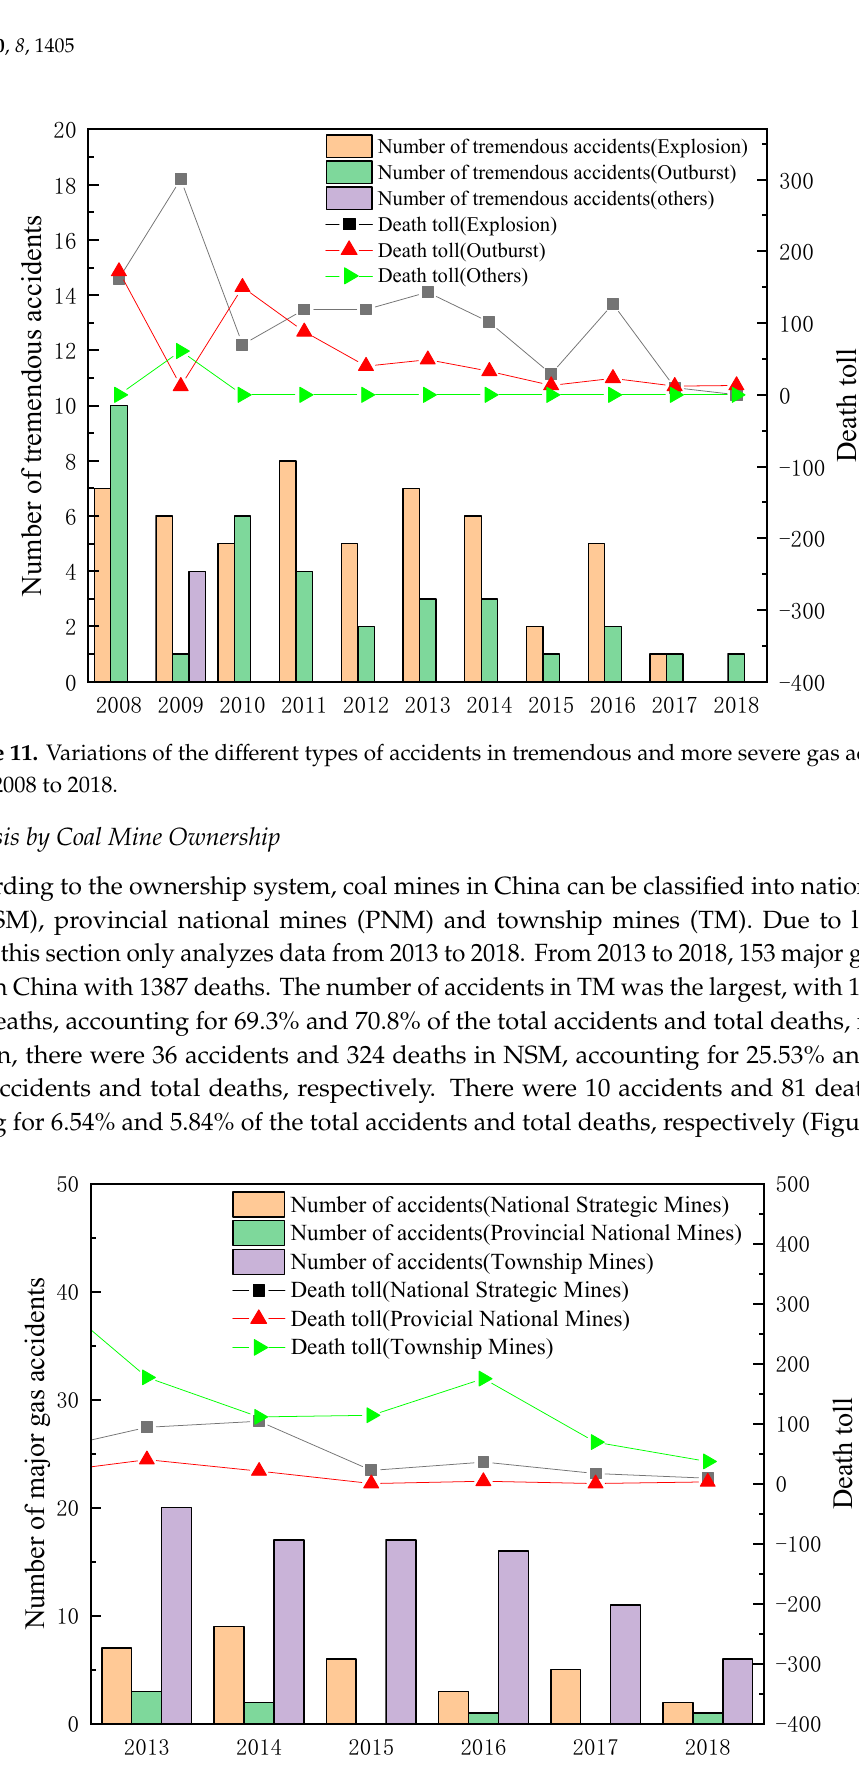
Figure 10. Variations of the different types of accidents in major gas accidents from 2008 to 2018.